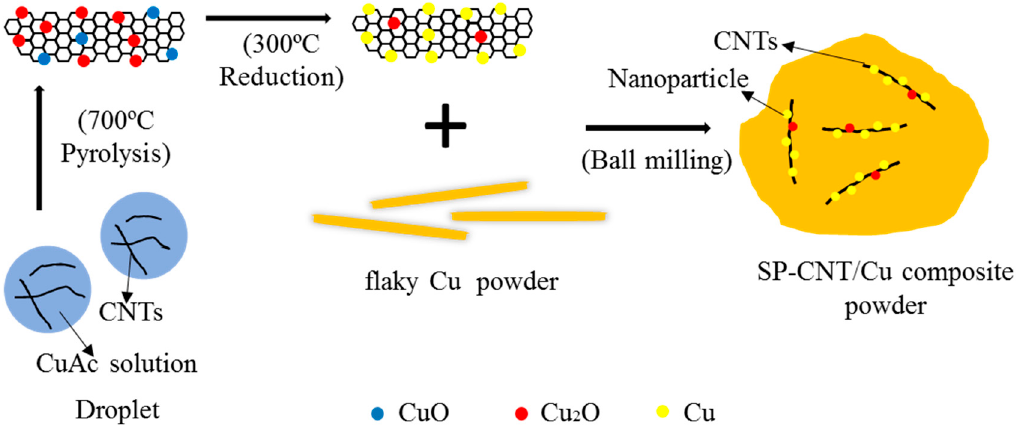
Figure 1. Illustration of fabrication procedure of CNT-Cu composite powder.